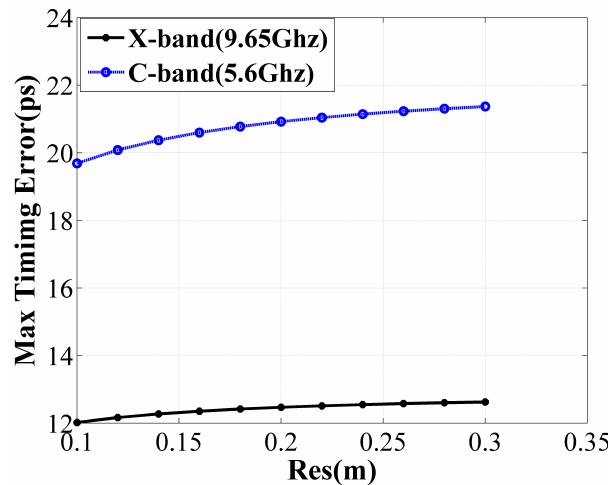
Figure 4. Upper limit of the timing error versus the slant-range resolutions for X-band and C-band SAR systems employing the synthetic bandwidth